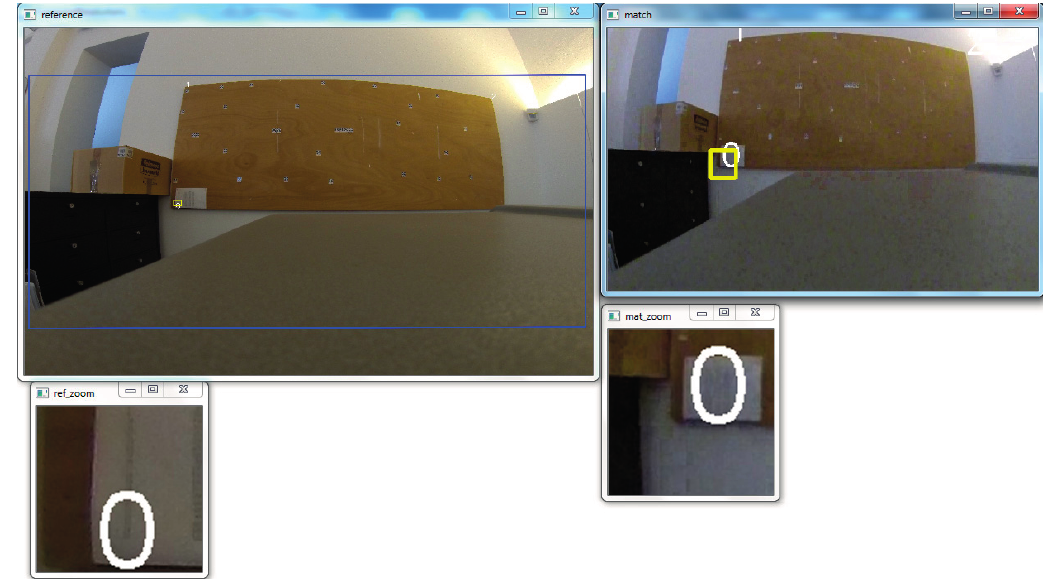
Figure 13. The affine transformation gave the part of the sensor used to capture the low resolution (848 × 480) video frames. The blue rectangle defines the placement of the low resolution image in the full frame